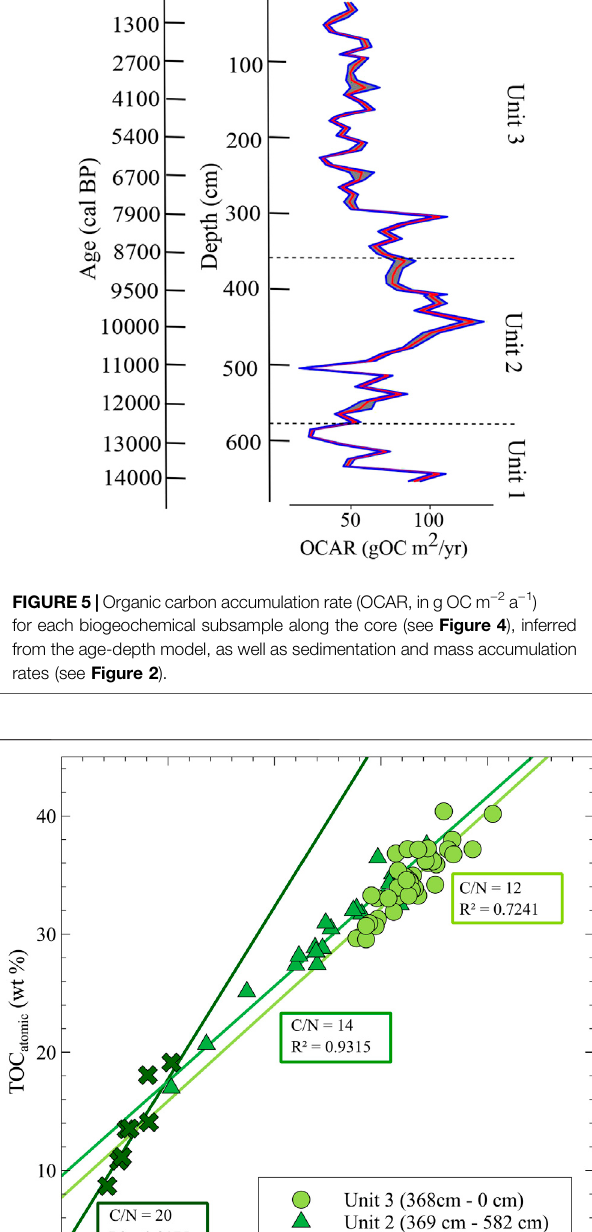
slightly higher average values compared to the other units (Unit 1 average: 1.9 wt% versus Unit 2 average: 0.6 wt%, Unit 3 average: 0.7 wt%) ( Figure 4 ). δ 13 C values decrease consistently throughout Unit 1 ( Figure 4 ). In the overlying units, δ 13 C values increase from